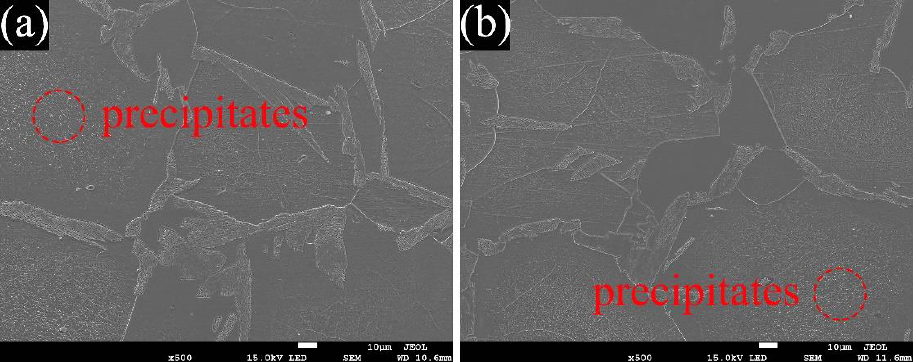
Figure 10. Microstructure of the fine-grain zone in the HAZ: ( a ) without ultrasonic treatment and ( b ) with ultrasonic treatment. Figure 11. SEM images of the fine-grain zone in the HAZ: ( a ) without ultrasonic treatment and ( b ) with ultrasonic treatment.